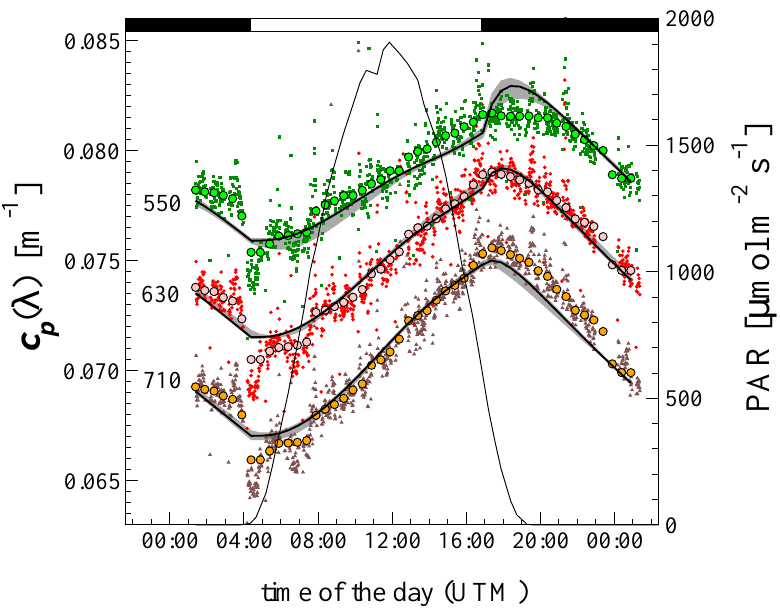
Fig. 3. Comparison between measured and modeled c p for day of the year 196. c p measured at different wavelengths (bold numbers) are presented as small colored dots together with their median filtered values used for the optimization (large circles). Gray shaded areas and thinner black lines are the 95% confidence intervals and median, respectively, of modeled c p at the same wavelengths ( n = 1 . 06). The photosynthetically available radiation (PAR) is plotted as the thin bell-shaped black line. Black and white bar at the top indicate the division-only and growth-and-division phases of the model, respectively.